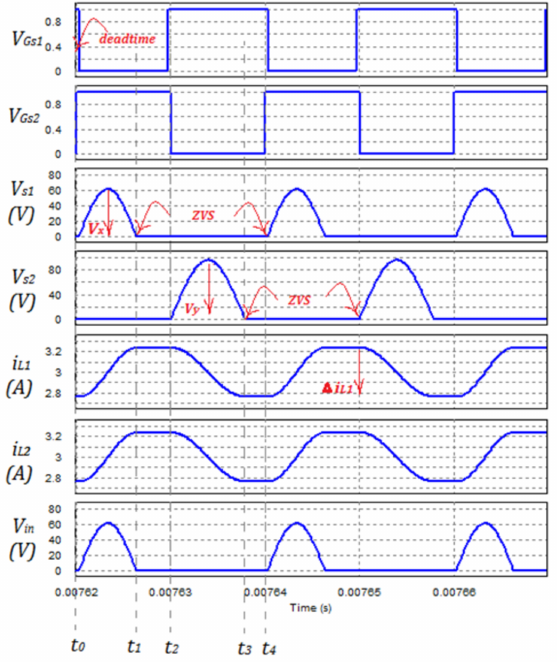
Figure 9. Theoretical simulation of inverting 1/2-type SDRSIC. Stage 1 [ t 0 − t 1 ]: S 1 is switched off and S 2 is turned on, both at t 0 . The circuit is